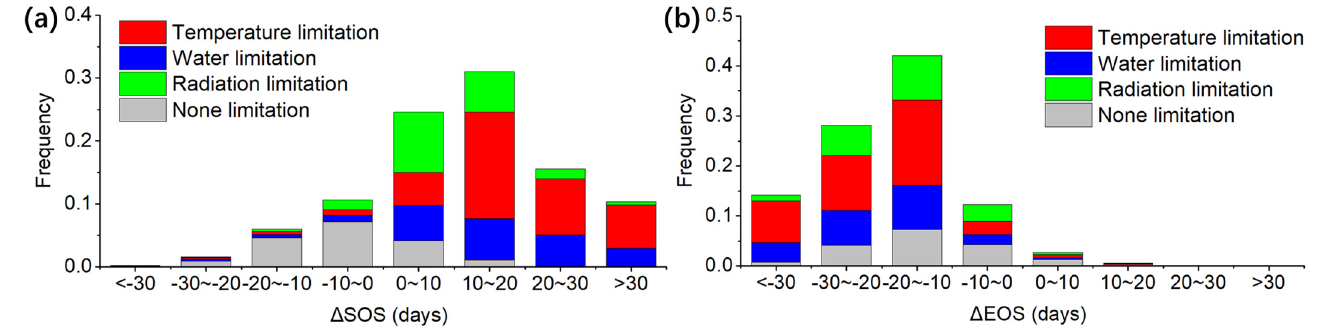
Figure 3. The differences in SOS ( a ) or EOS ( b ) derived from SIF and EVI among different climatic limitation areas.